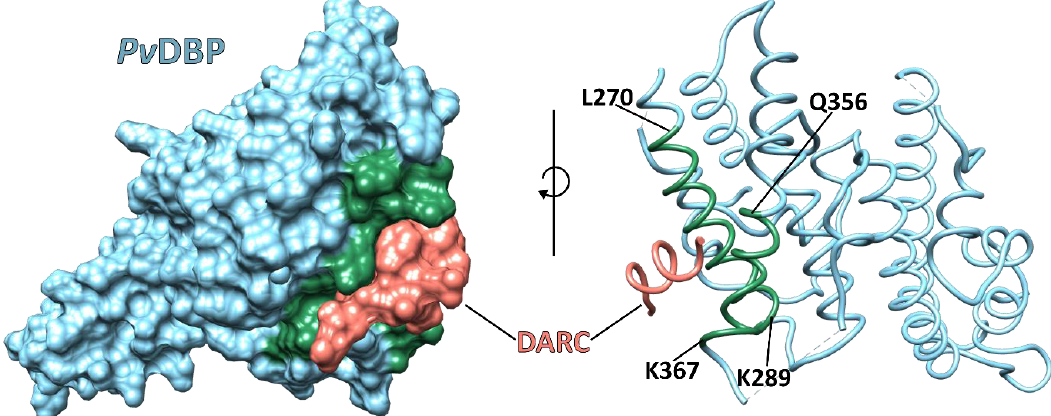
Figure 2. Crystal structure of Pv DBP-RII bound to the DARC core region (PDB: 4NUU). The Pv DBP-RII region that interacts with the DARC consists of residues 256-426 located in SD2. Binding develops in a stepwise manner to create a stable, two-molecule heterotetramer consisting of two DBP (blue) copies and two molecules of the DARC (salmon). Green represents the Pv DBP-RII helices forming the receptor binding pocket [28].